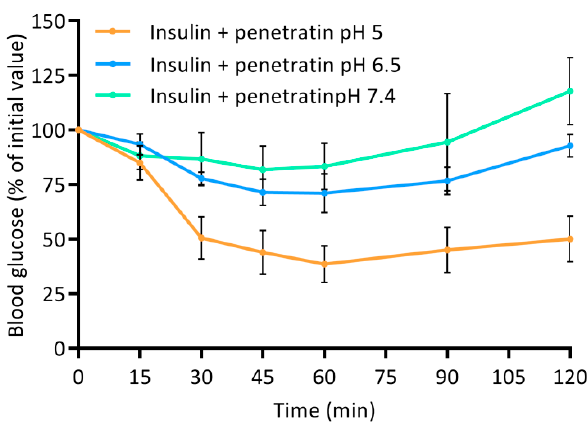
(Figure S7). Administration of insulin alone at pH 7.4 or penetratin alone at pH 5 did not affect the blood glucose level